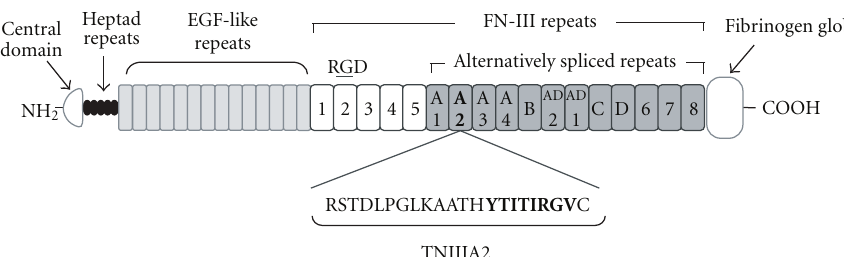
Figure 1: Schematic illustration of tenascin-C domain structure. Sequences analogous to antiadhesive peptide, FNIII14 (YTIYVIAL), are presented in alternative splicing region of